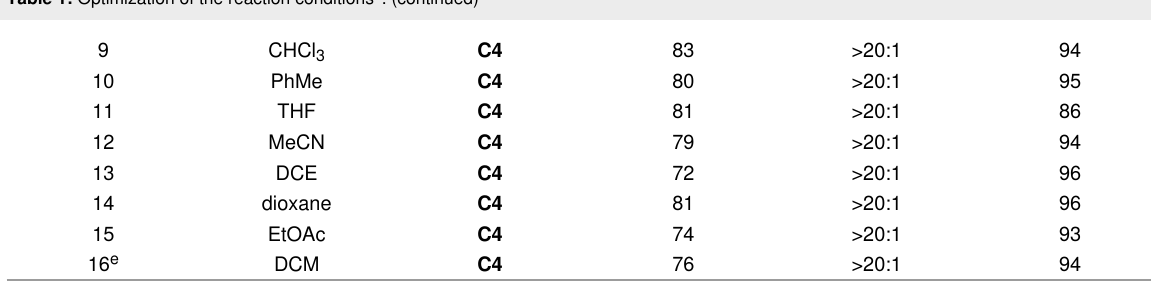
Table 1: Optimization of the reaction conditions a . (continued)